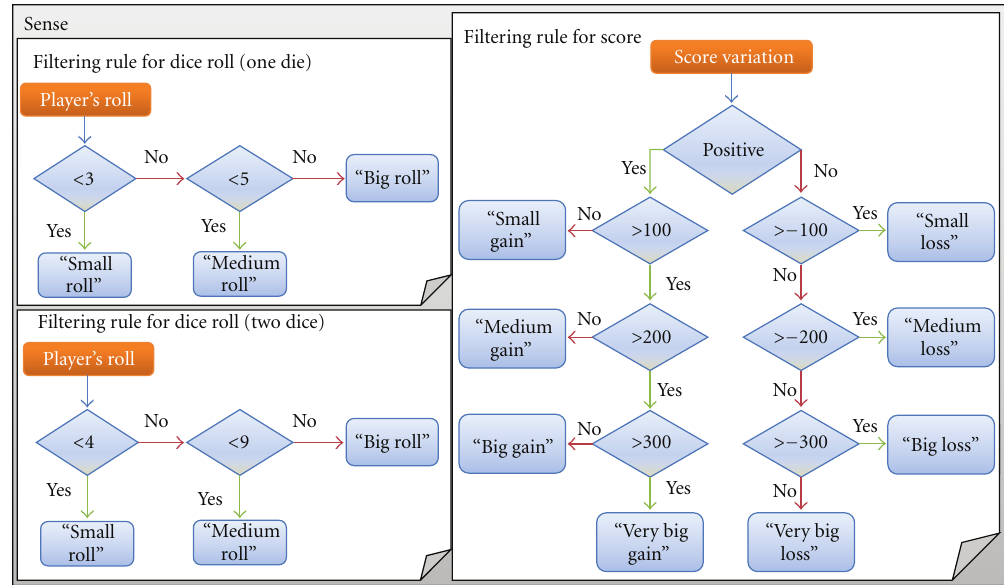
Figure 4: Examples of filtering